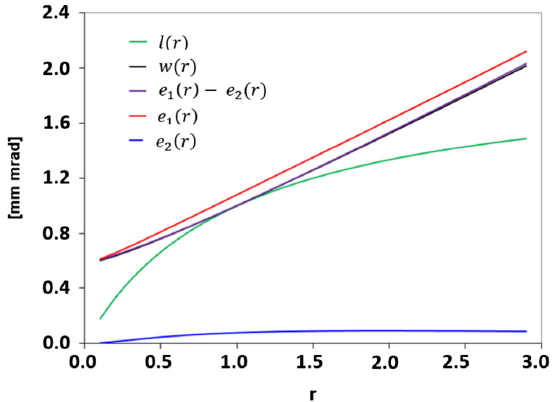
FIG. 11. Angular momentum (green), beam phase integral or vorticity (black), difference of eigenemittances (violet), and the two eigenemittances (red and blue) as functions of the geometric aspect ratio r